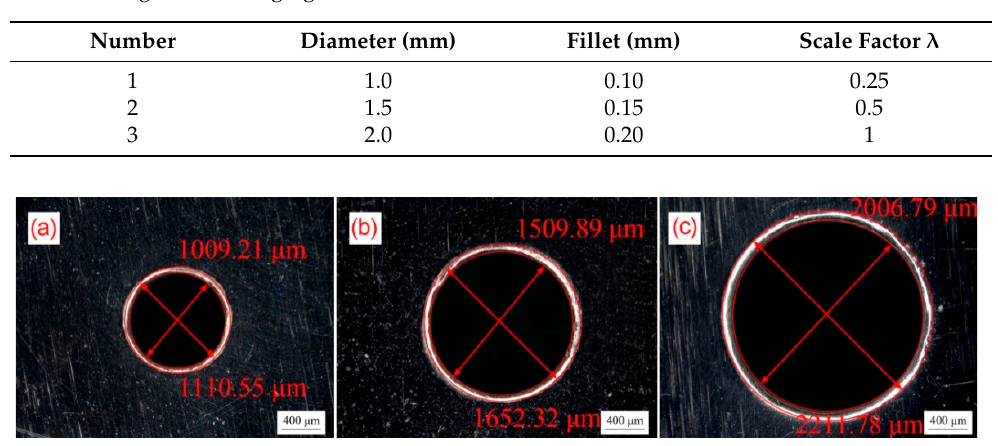
Figure 3. Real product photo of bulging molds. ( a ) λ = 0.25; ( b ) λ = 0.5; ( c ) λ = 1.